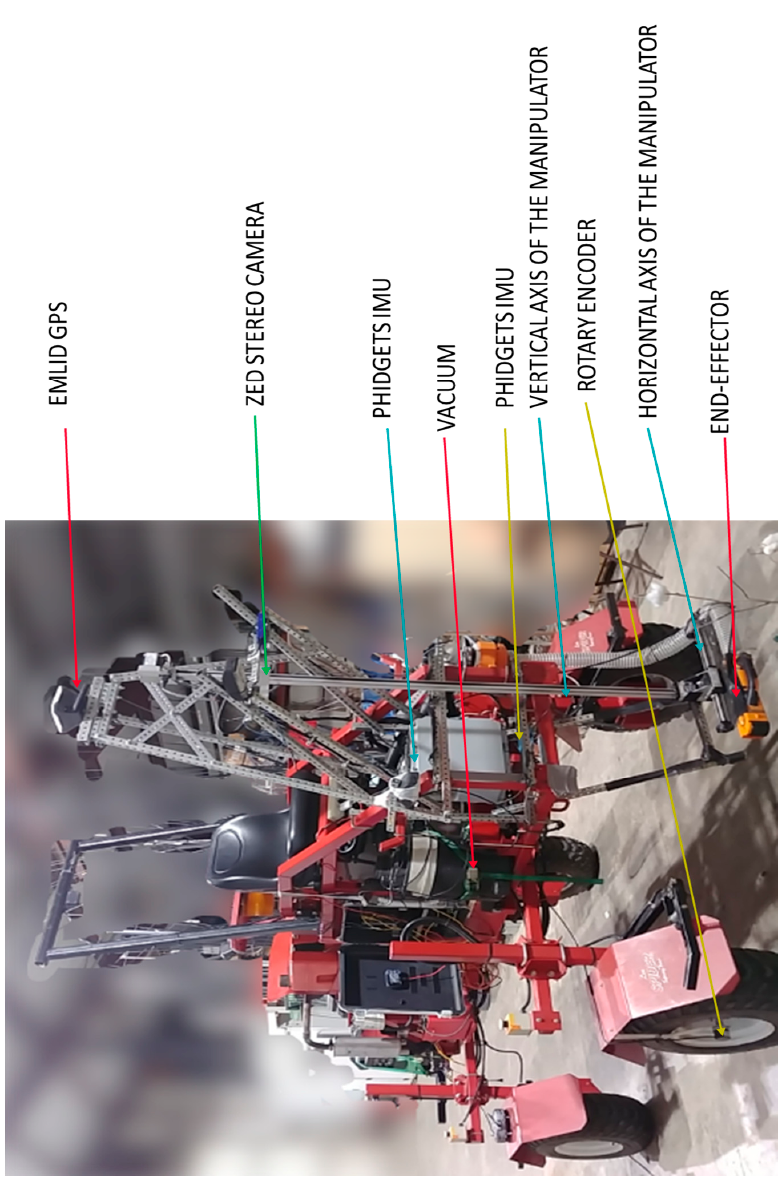
Figure 2. The red research rover with manipulator and sensors attached in front of the